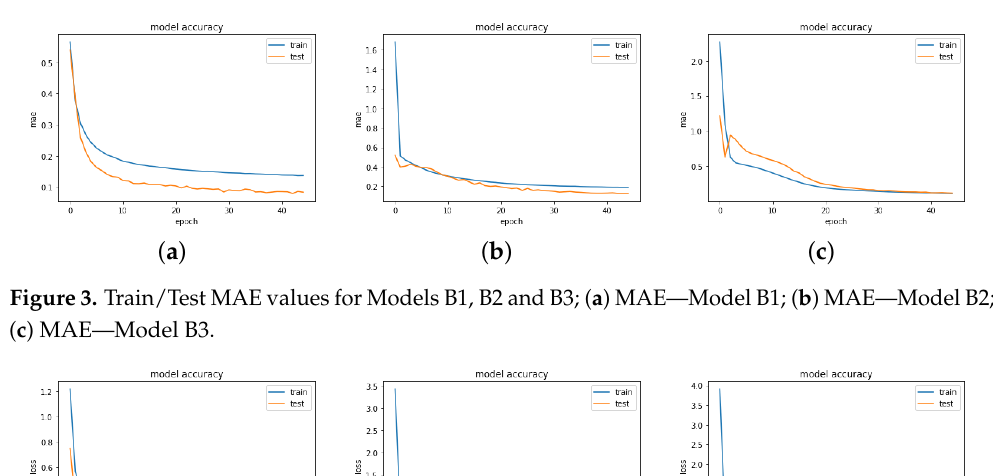
Figure 2. Train/test MAE values for Models A1, A2 and A3; ( a ) MAE—Model A1; ( b ) MAE— Model A2; ( c ) MAE—Model A3.